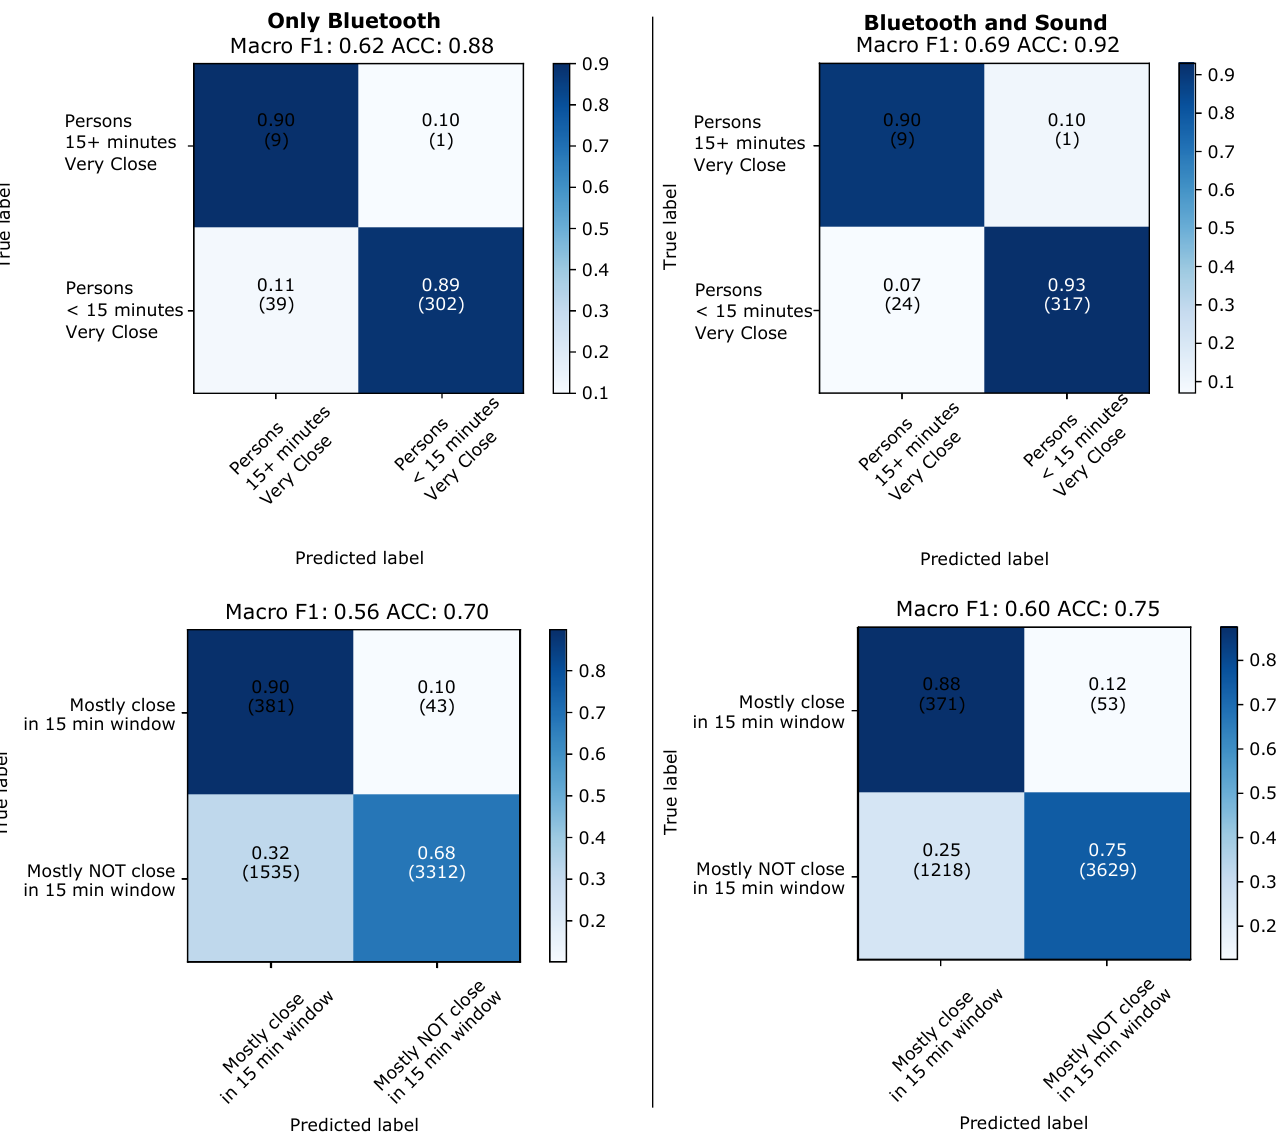
Figure 18. Train one place, test on the other. Comparing people that can be detected being close 15 min or more using different